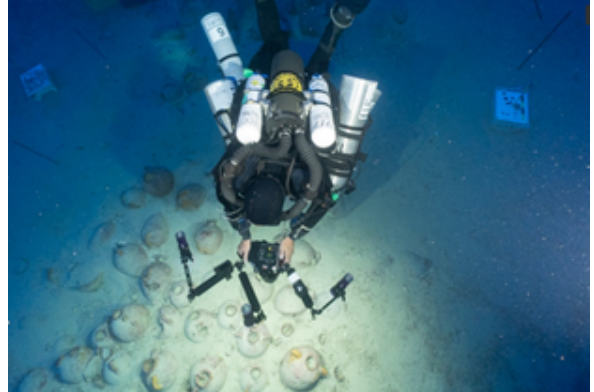
Figure 3. Excavation on Xlendi by divers with rebreathers at 110 meters depth. Photo: K. Hyttinen